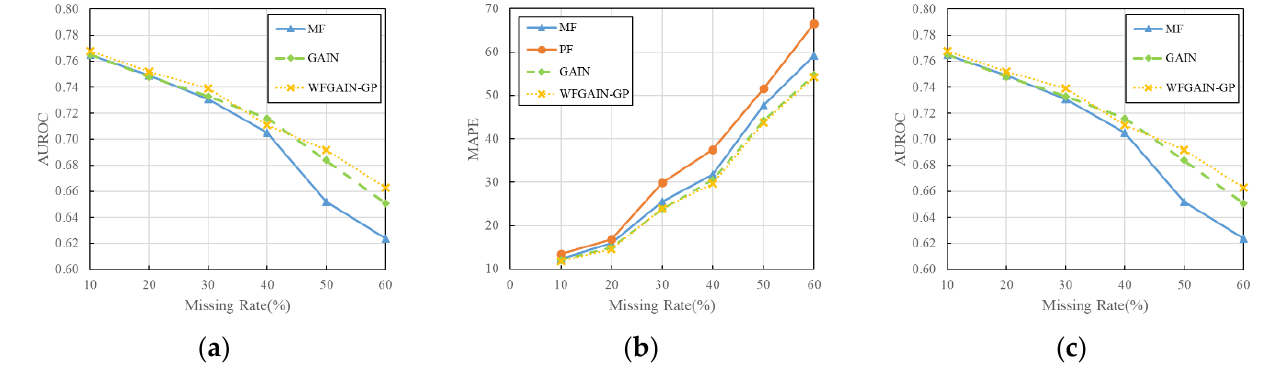
Figure 6. Performance comparison of different models under different missing rates: ( a ) RMSE, ( b ) MAPE, and ( c ) AUROC.